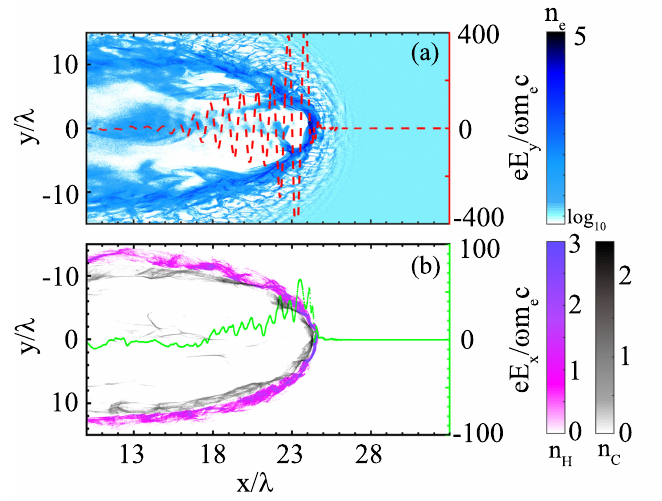
Figure 6. ( a ) The electron density (with the colorbar in a log scale) at t = 35 T 0 , where the laser field along the axis y = 0 is plotted by the red dashed line. ( b ) The densities of protons ( n H ) and carbon ions( n C 6 + ) with the colorbar in a log scale, where the longitudinal electric field E x along the axis y = 0 is plotted by the green dotted line.